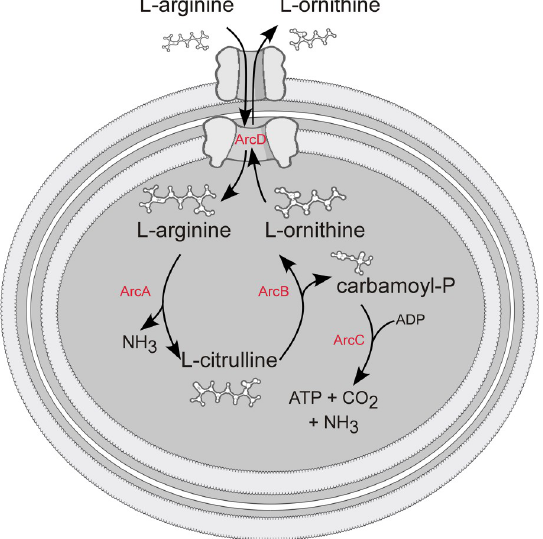
Fig 1. The bacterial arginine deiminase system (ADI) facilitates the transport and catabolism of L-arginine. Bacterial ADIs use the antiporter, ArcD, to import L-arginine and export L-ornithine. Once inside the cell, L-arginine is broken down into L-citrulline by arginine deiminase (ArcA), then to L-ornithine by ornithine transcarbamylase (ArcB). Carbamate kinase (ArcC) converts carbamoyl phosphate to ammonia, carbon dioxide and